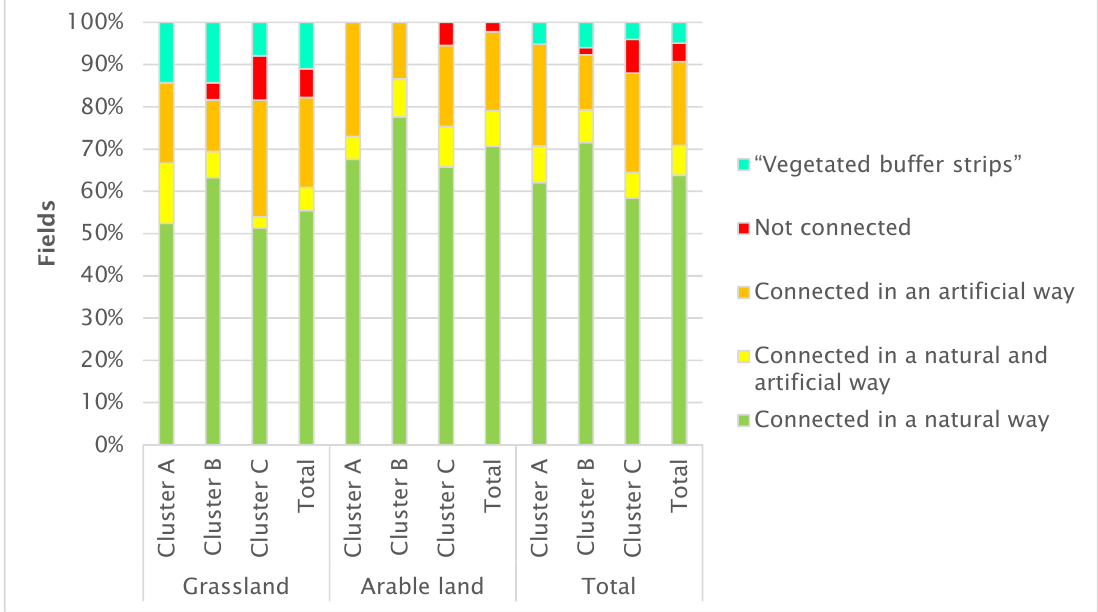
Figure 4. Proportions of the assessed connectivity types among the mapped clusters and agricultural land use types. The results indicate a rather low overall variability (“Vegetated buffer strips” can be considered as grassland fields connected in a natural